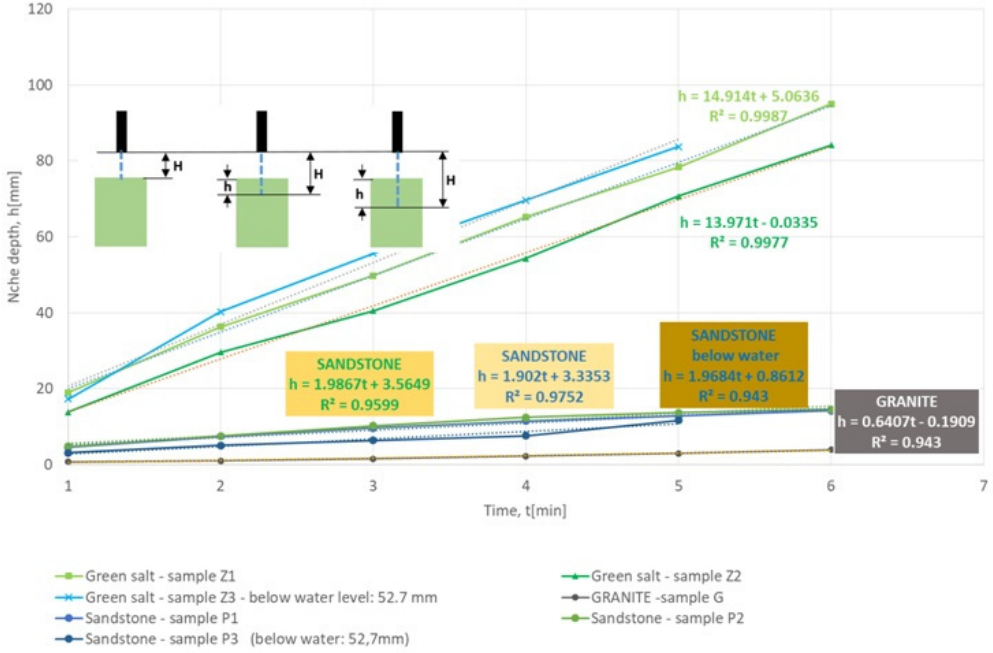
Figure 7. Comparison of average depth of cut niche as a function of water cutting time for various rocks. Nozzle’s displacement velocity v = 100 (mm / min). Water jet pressure p = 500 bar.